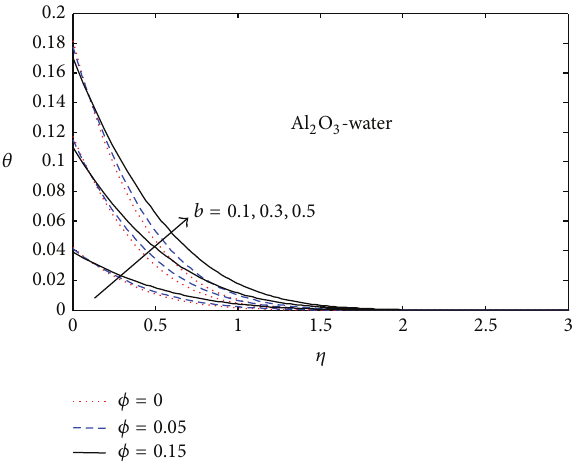
Figure 4: 𝑛 = 2 , 𝑓 𝑤 = 0.5 , Pr = 6.2 , 𝑀 = 0.5 , and 𝐴 = 0.5 .